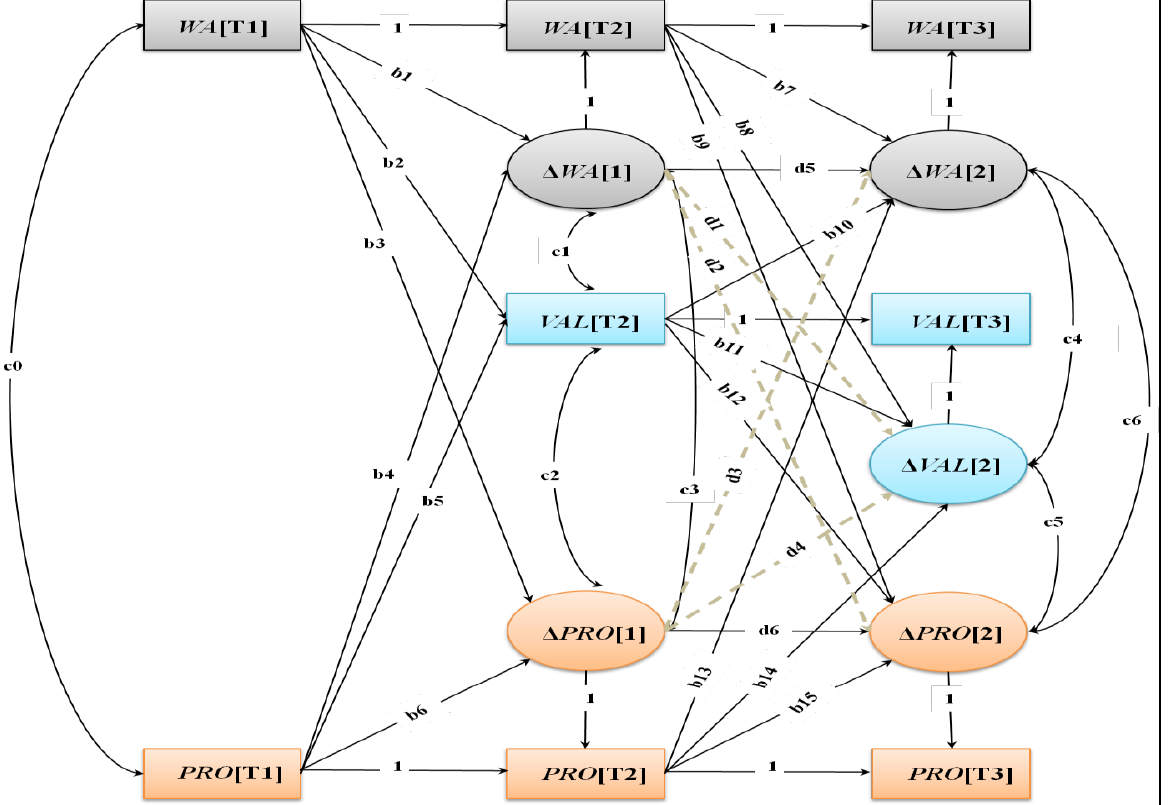
Figure 1. Multivariate Change Model of Parental Warmth, Family Values, and Children’s Prosocial